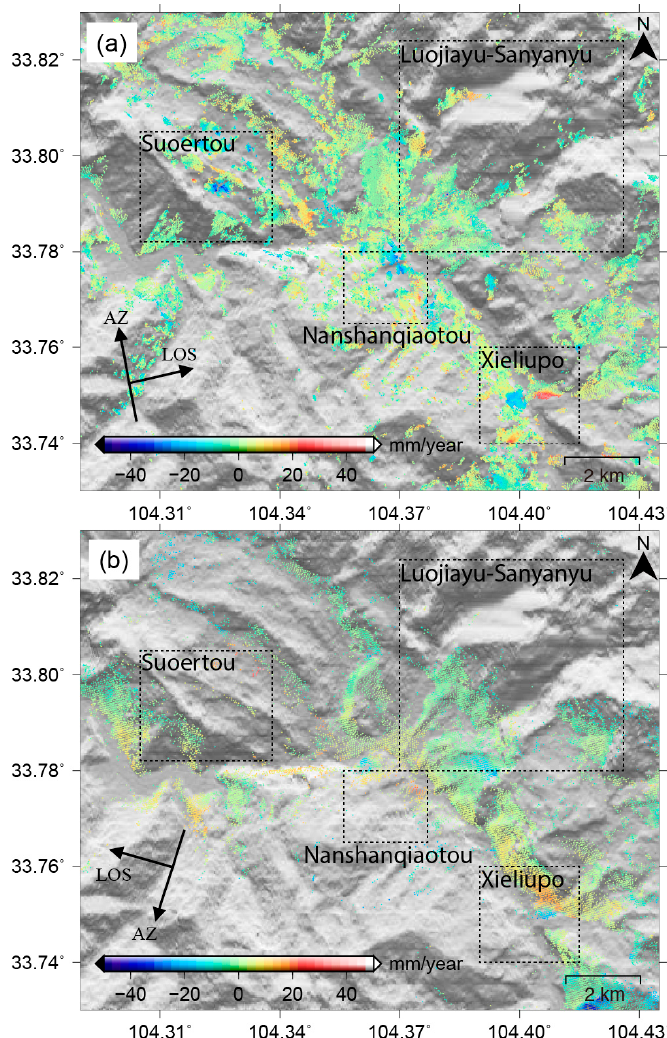
Figure 8. LOS deformation rate fields over the study area estimated from ALOS ascending ( a ) and ENVISAT descending ( b ) datasets, respectively, which are superimposed on Advanced Spaceborne Thermal Emission and Reflection Radiometer Global Digital Elevation Model (ASTER GDEM)-derived topography. AZ and LOS indicate the azimuth and the LOS directions, respectively. Dashed boxes indicate the regions affected by the landslides.